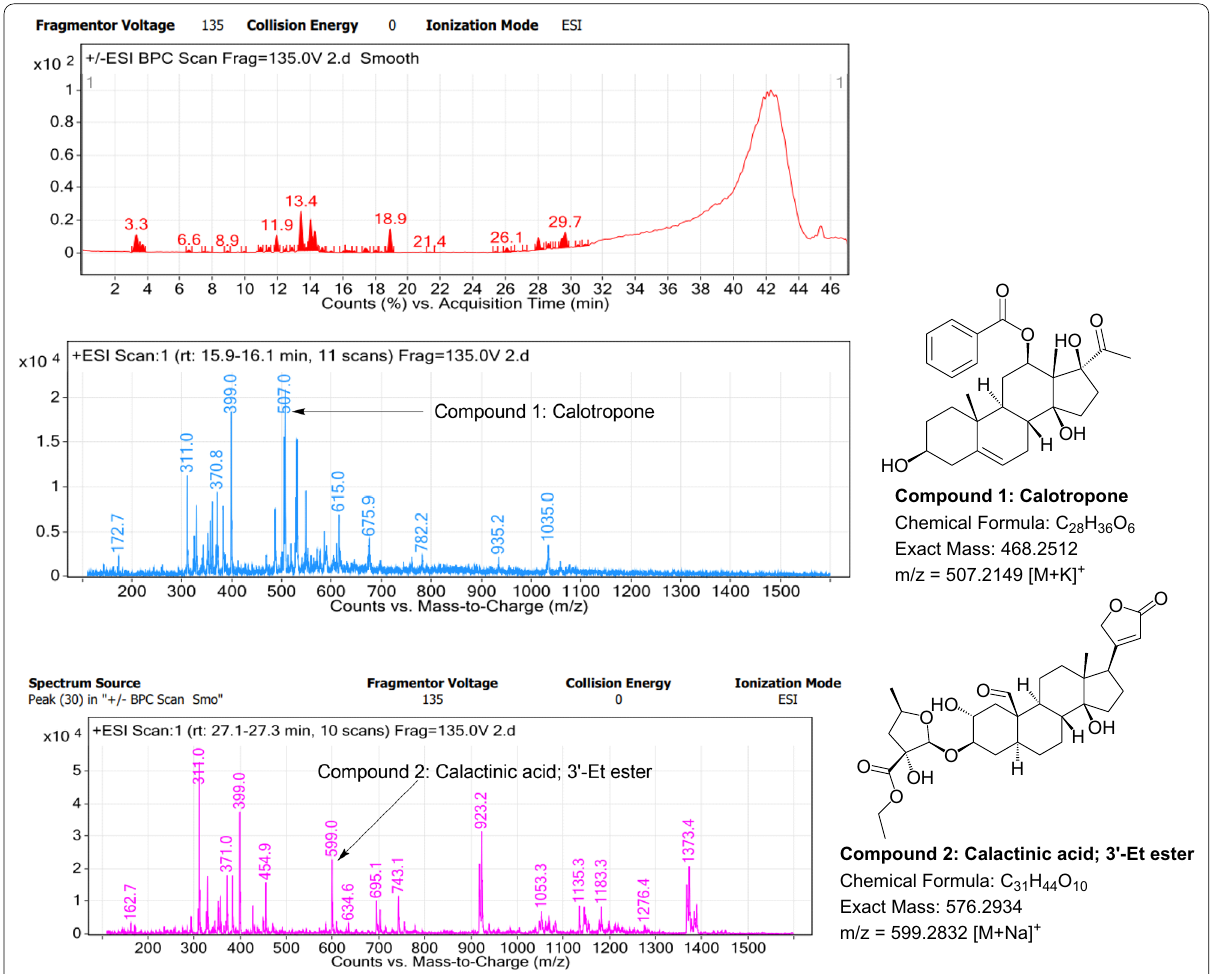
Fig. 8 LC–MS chromatogram of root extract of Calotropis gigantea showing marker